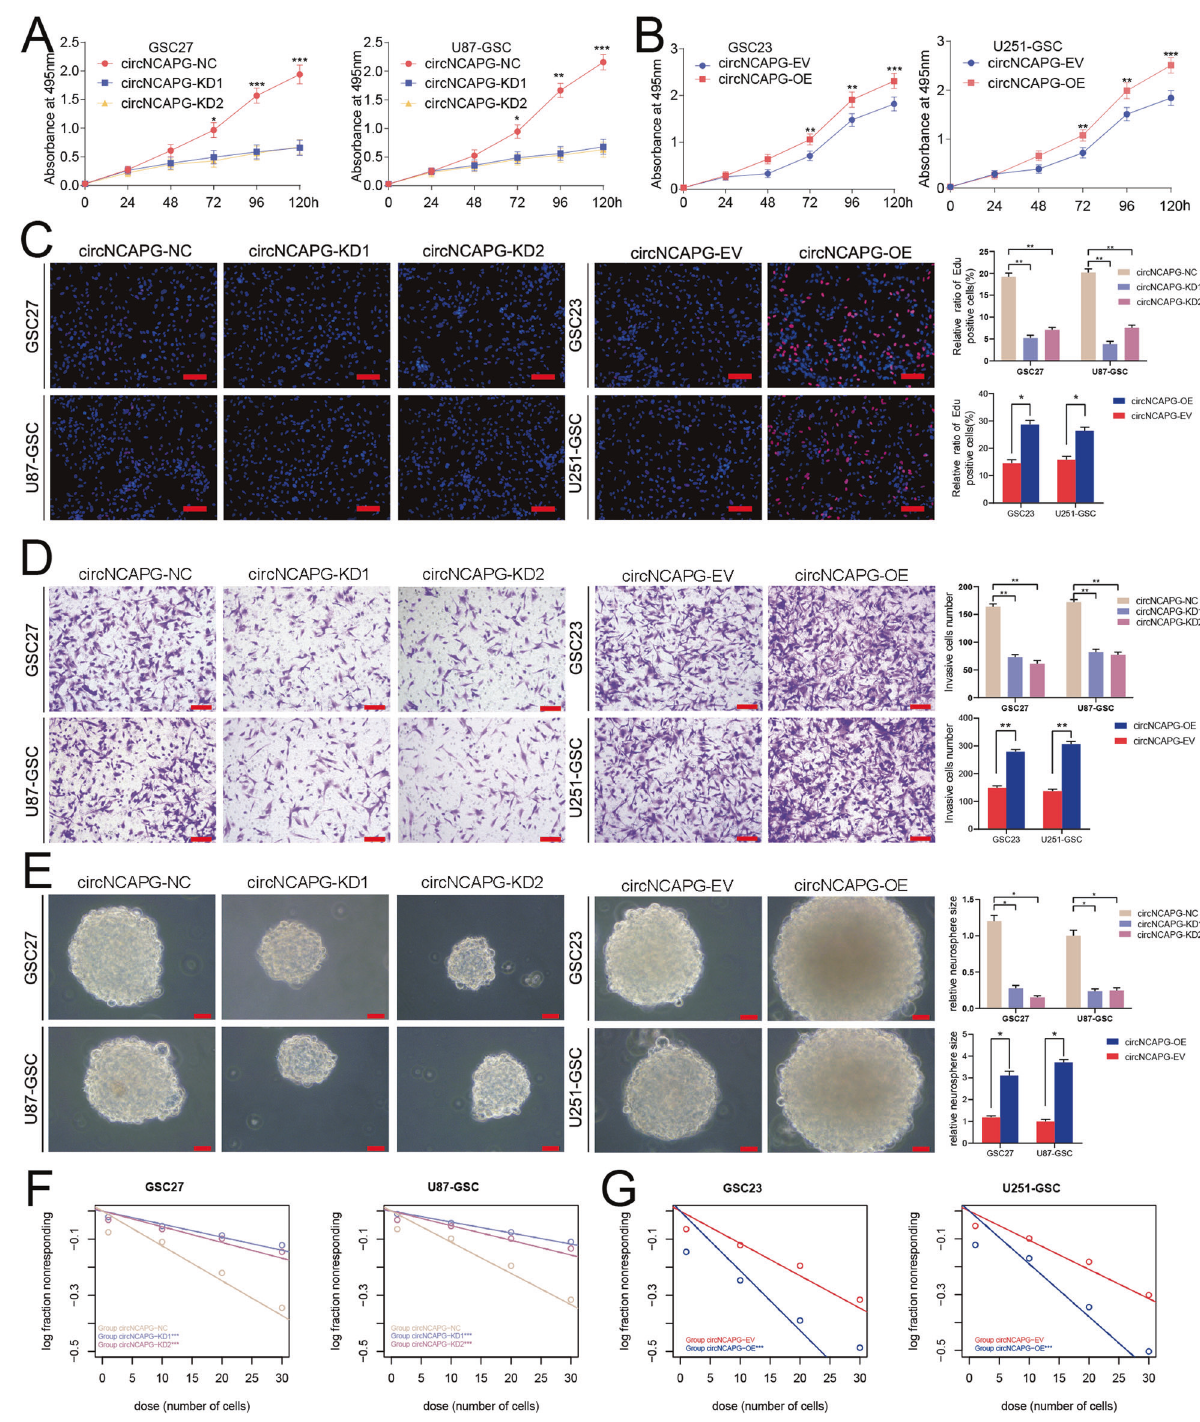
Fig. 2 circNCAPG promotes the malignant phenotype of GSCs in vitro. A , B The MTS assays revealed the cell viability of different GSC groups after circNCAPG knockdown and overexpression treatment. C The Edu assays demonstrated the proliferation of different GSC groups after circNCAPG knockdown or overexpression treatment. Scale bar = 100 µm. D The transwell assays showed the invasive capability of GSC groups after circNCAPG knockdown or overexpression treatment. Scale bar = 50 µm. E The neurospheres formation assays revealed the neurospheres sizes of different GSC groups after circNCAPG knockdown or overexpression treatment. Scale bar = 20 µm. F , G The limiting dilution assays revealed the neurosphere-forming capacity of different GSC groups after circNCAPG knockdown or overexpression treatment. All results are presented as the mean ± SD (three independent experiments). * p < 0.05; ** p < 0.01; *** p < 0.001.